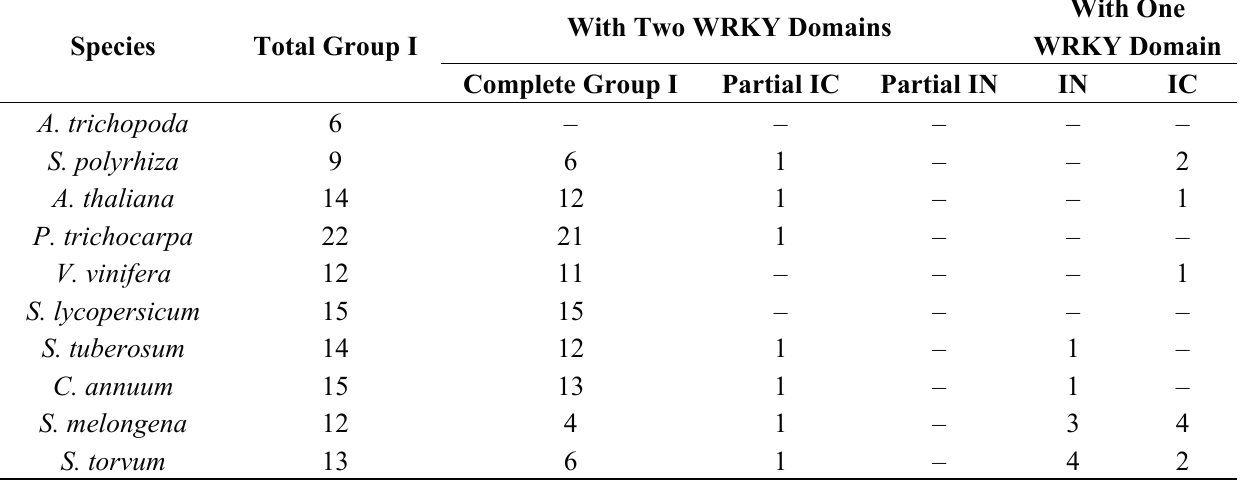
Table 2. The distribution of subgroups of Group I WRKY TFs from ten plant species. IN, N -terminal WRKY domain; IC, C -terminal WRKY